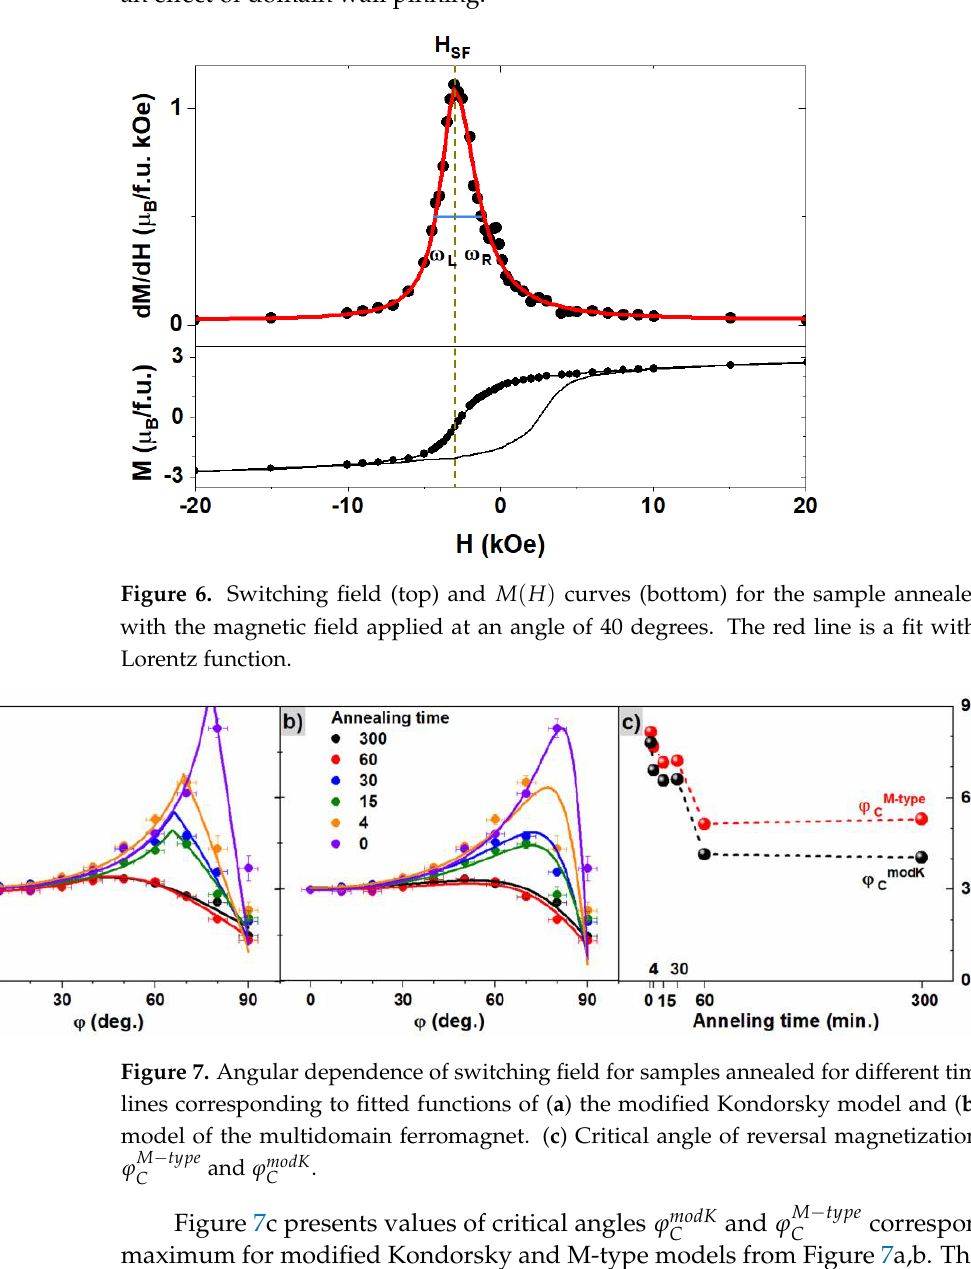
Figure 6. Switching field (top) and 𝑀(𝐻) curves (bottom) for the sample annealed for 60 min with the magnetic field applied at an angle of 40 degrees. The red line is a fit with asymmetric Lorentz function.